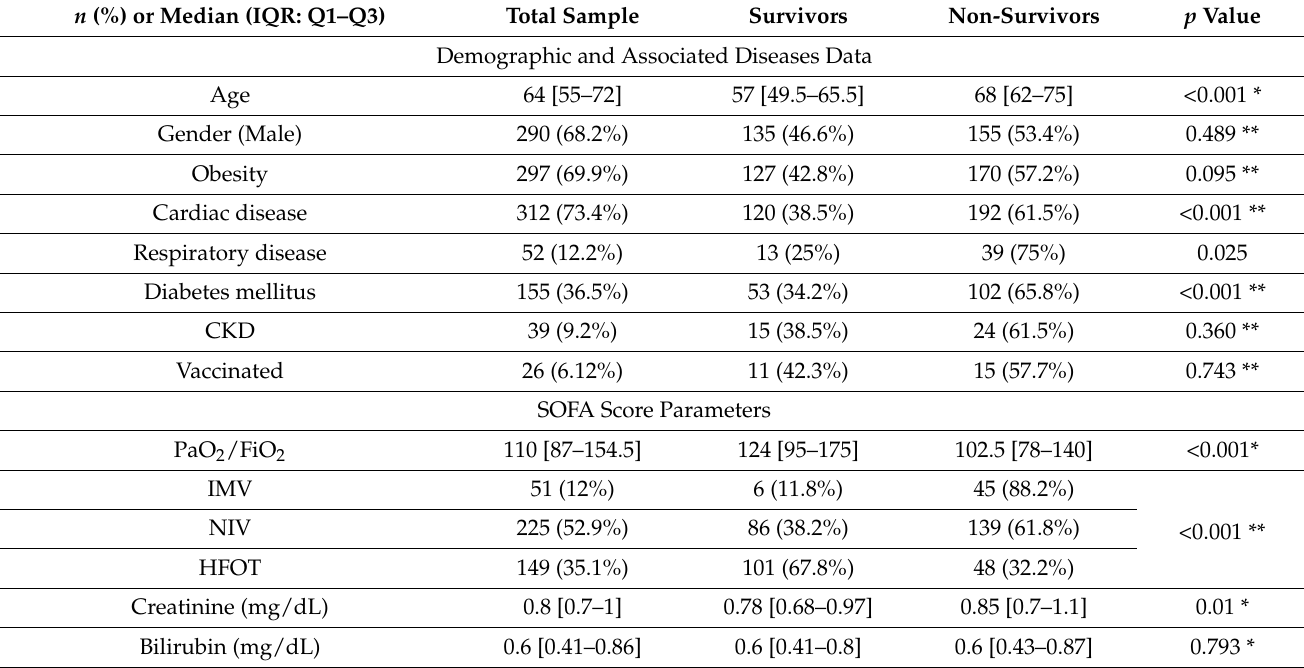
Table 1. Baseline characteristics of the study population at ICU